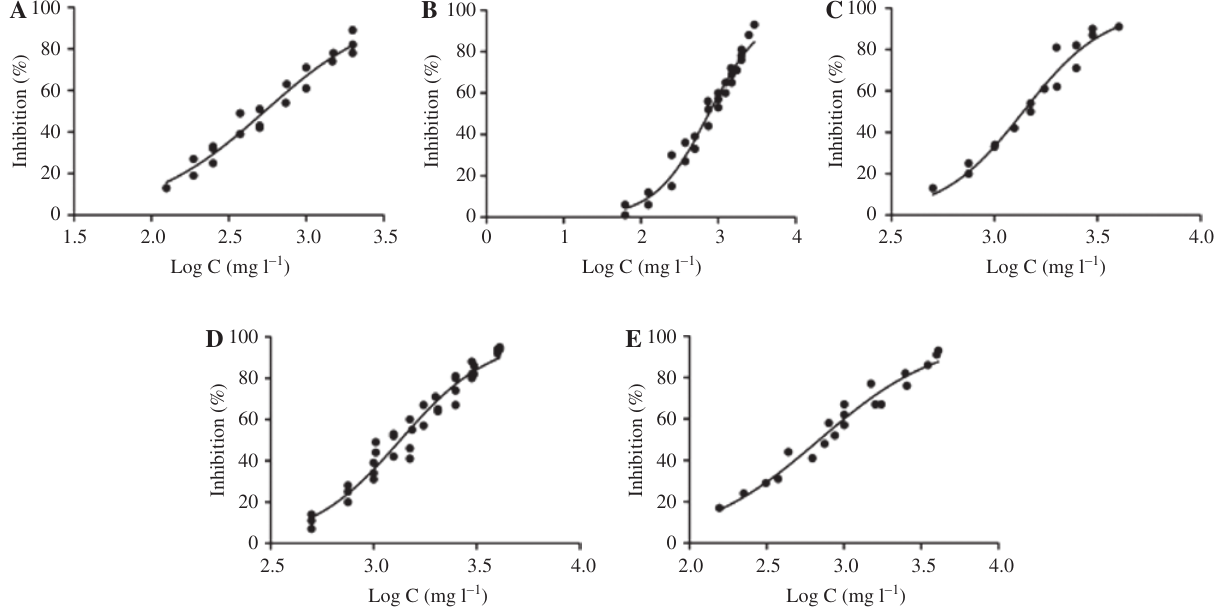
, (B) BM , (C) BM , (D) B, (E) P. 2 3 4